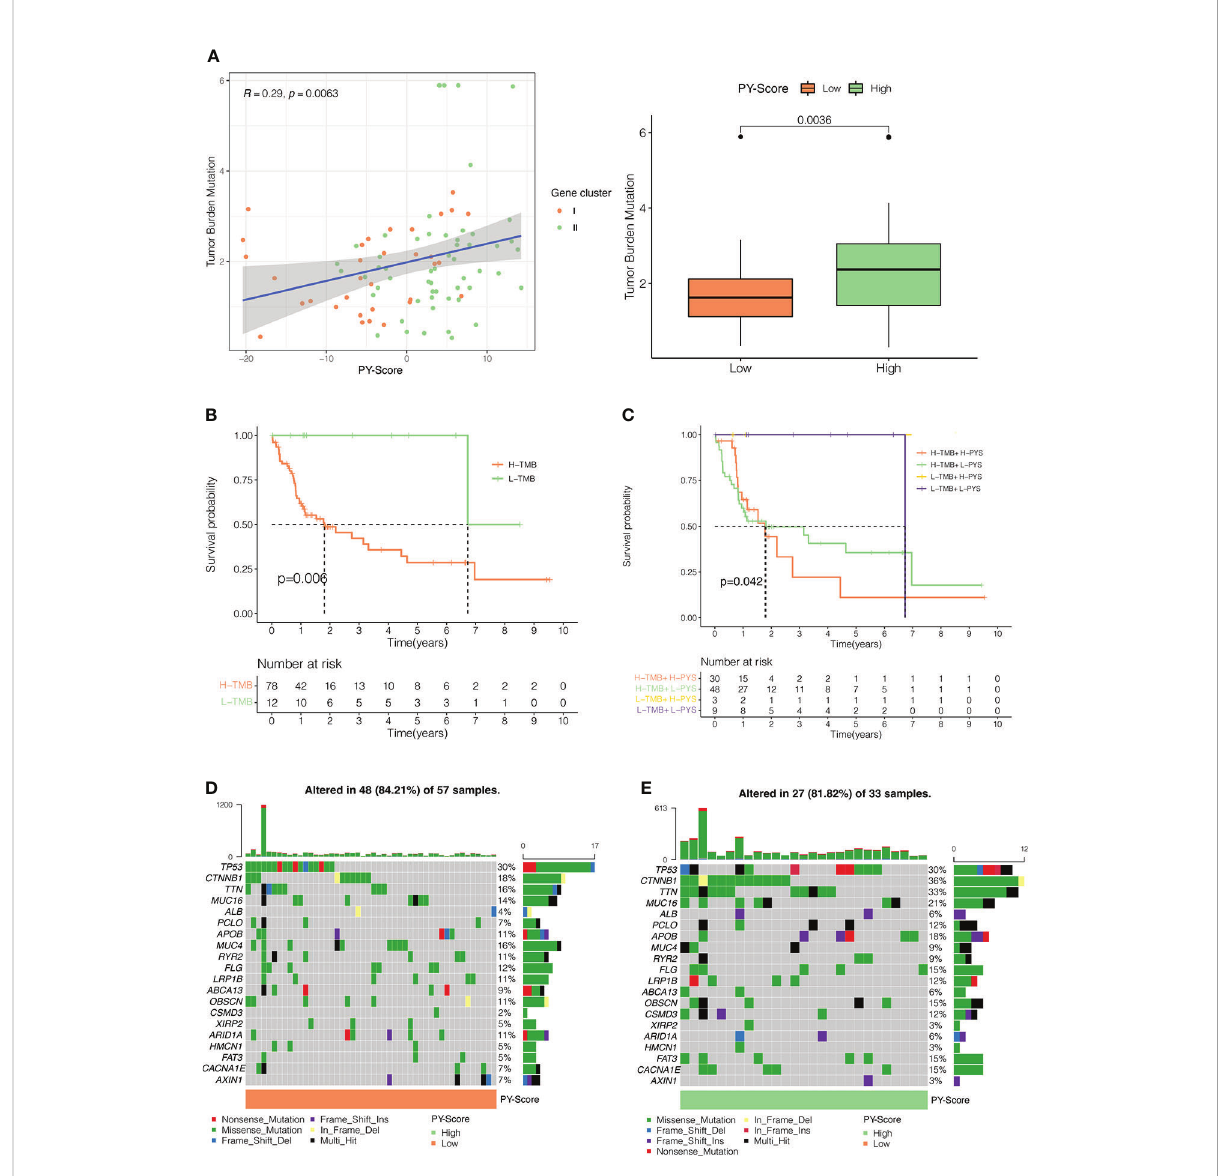
FIGURE 6 The Inner link between the PYS and TMB. (A) The correlation between the PYS and TMB. P< 0.01. (B) Survival curves for high and low TMB groups in the TCGA-HBV-LIHC cohort. P =0.006. (C) Survival curves for HBV-HCC patients classi fi ed by TMB and PYS. The oncoplot was constructed via the low-PYS group (D) and high-PYS group (E)